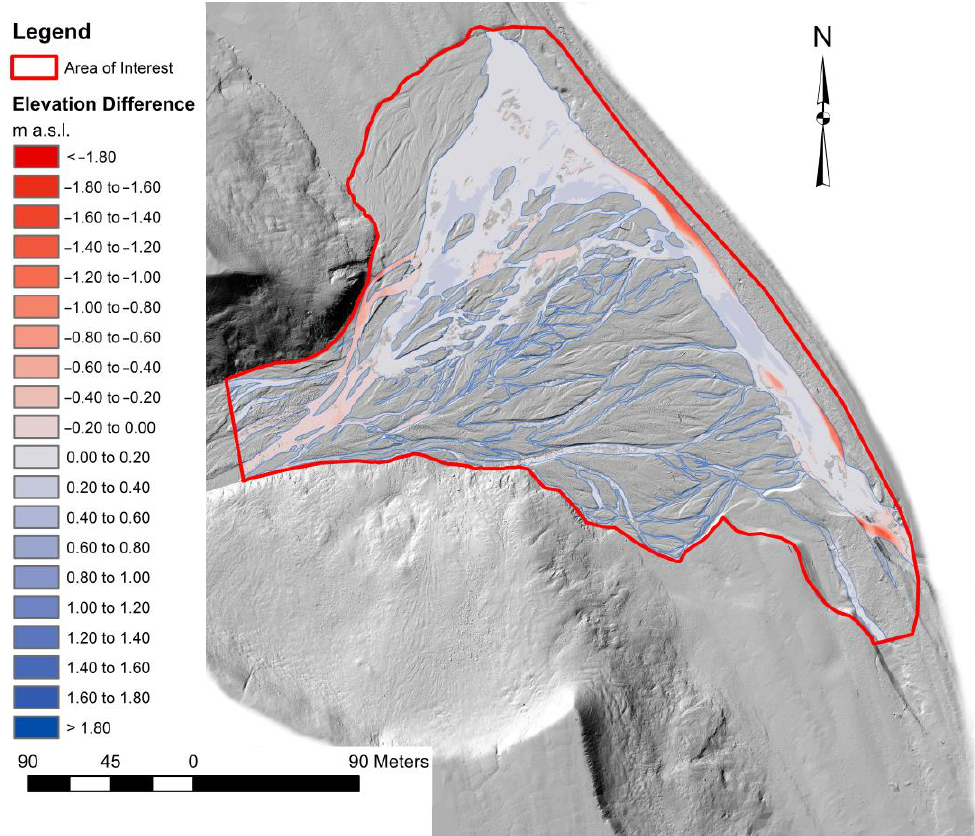
Figure 6. Geomorphic changes of the Scott River alluvial fan flooded area of interest for the 2013 flood period. AoI FA for the flooded area with MinLoD = 0.02. Hillshades map is shown after DoD for context. Table 3. Geomorphic changes in the Scott River alluvial fan non-flooded area (AoI NFA ) during the August 2013 flood event calculated using the DoD method in GCD software. Uncertainty was calculated using a minimum detection level (minLoD) of 0.02